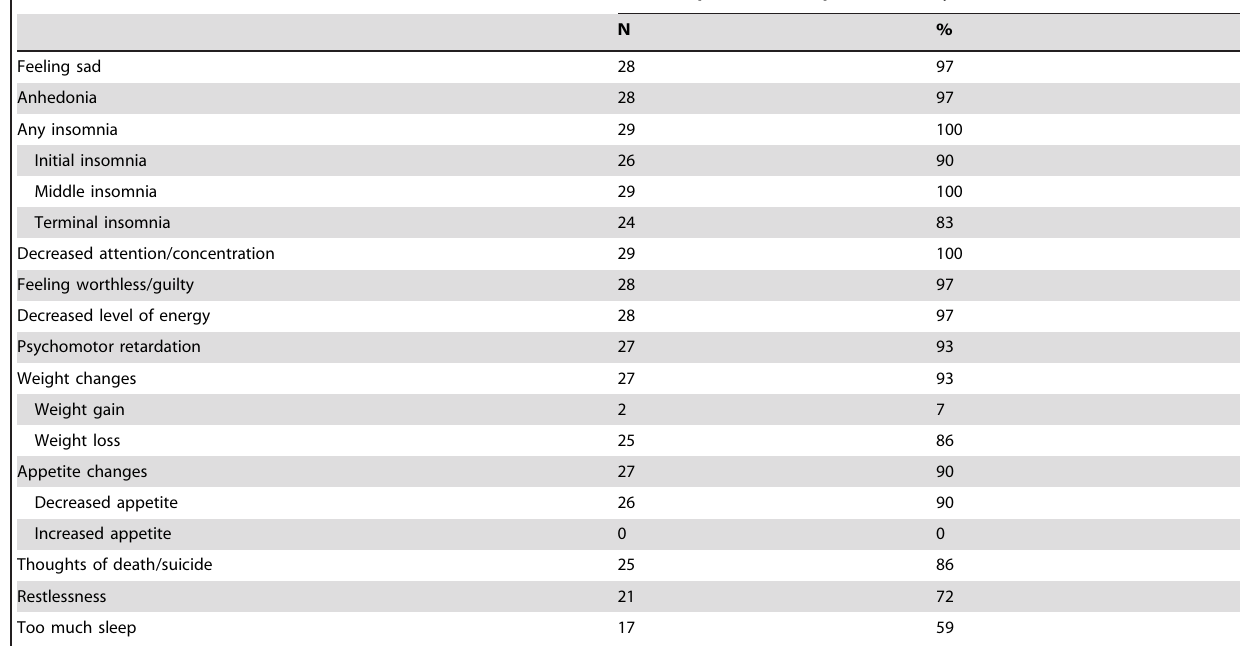
Table 3. Depressive symptoms endorsed.